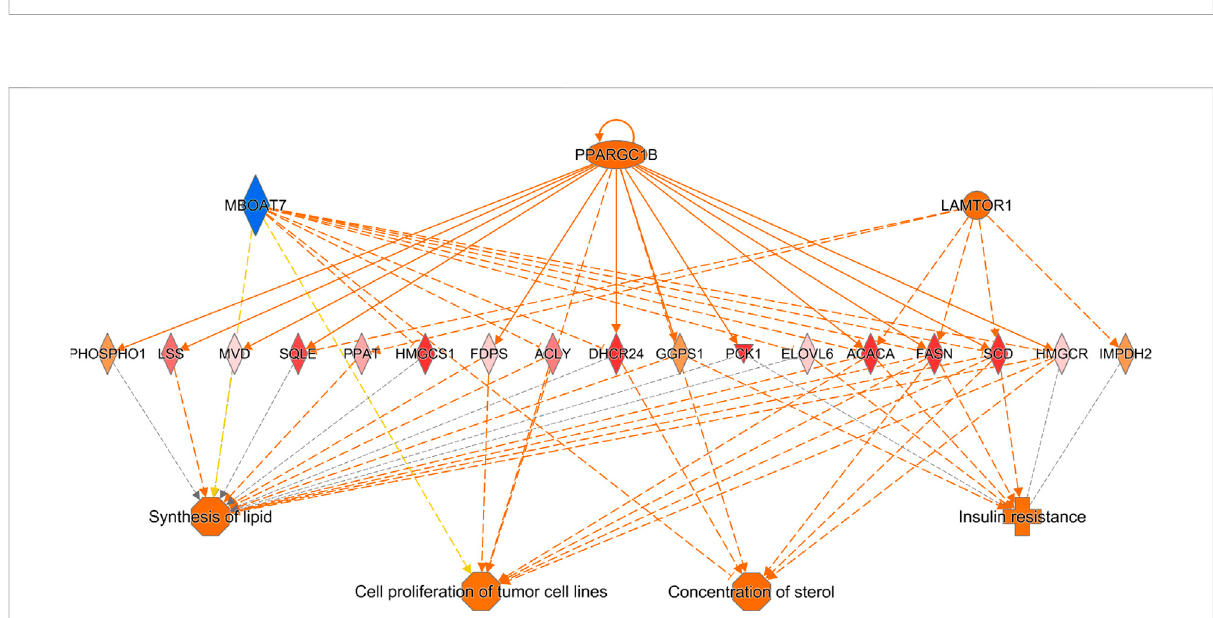
Network mapping of differentially expressed genes associated with cholesterol and fatty acid synthesis between FED chicks and E18 embryos. Networkmappingofdifferentiallyexpressedgenes(fold-change ≥ 5;FDR p -value ≤ 0.05)associatedwithcholesterolandfattyacidsynthesisbetween FED and E18. Many of the major enzymes associated with cholesterol and fatty acid synthesis weresigni fi cantly upregulated in FED chicks relativeto embryos. Red molecules were signi fi cantly upregulated and green molecules signi fi cantly downregulated in FED chicks. Orange indicates predicted activation and blue indicates predicted